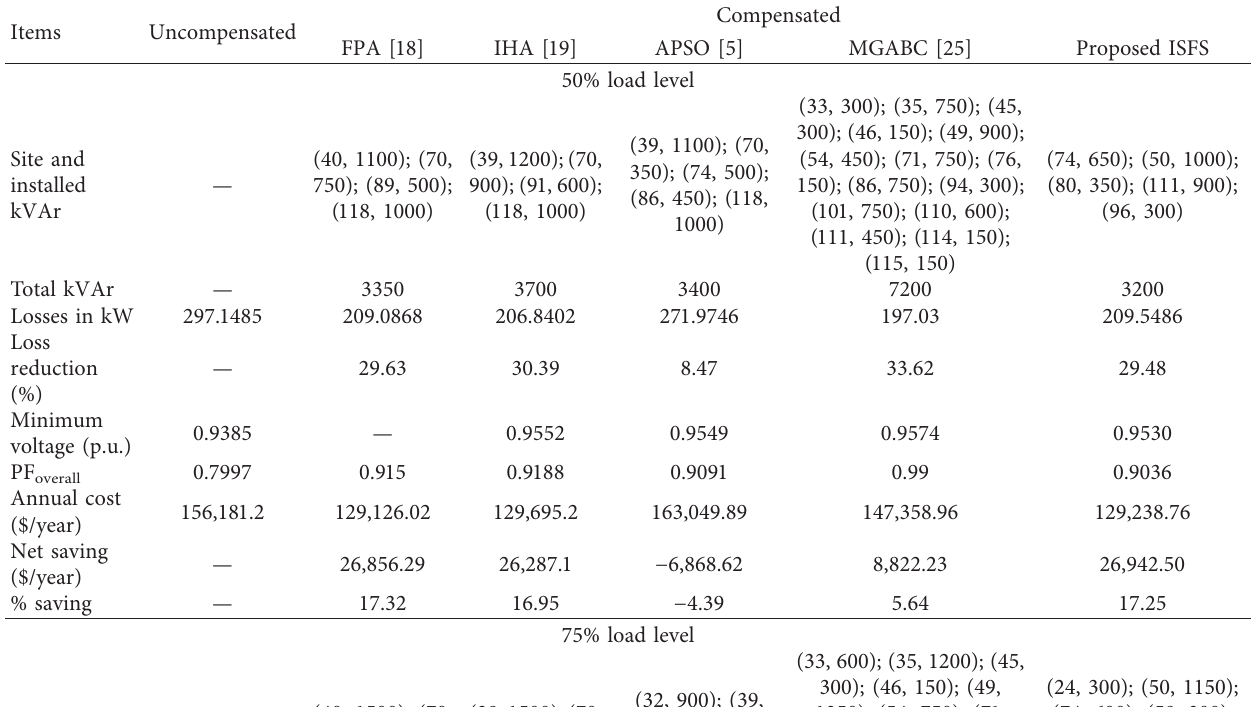
Table 6: Simulation results and comparison for 119-bus network at different loading conditions in scenario